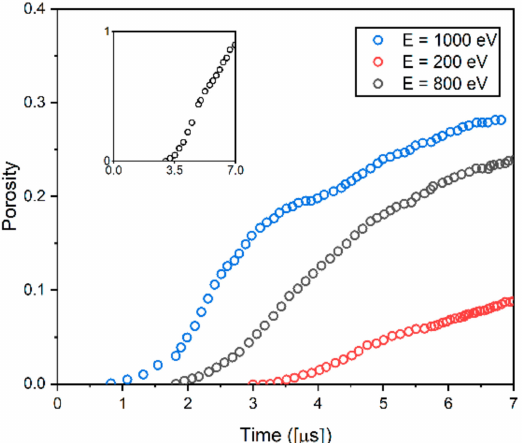
Figure 6. The evolution of porosity at T = 1000 K as a function of irradiation energy. Porosity is defined as a volume fraction of